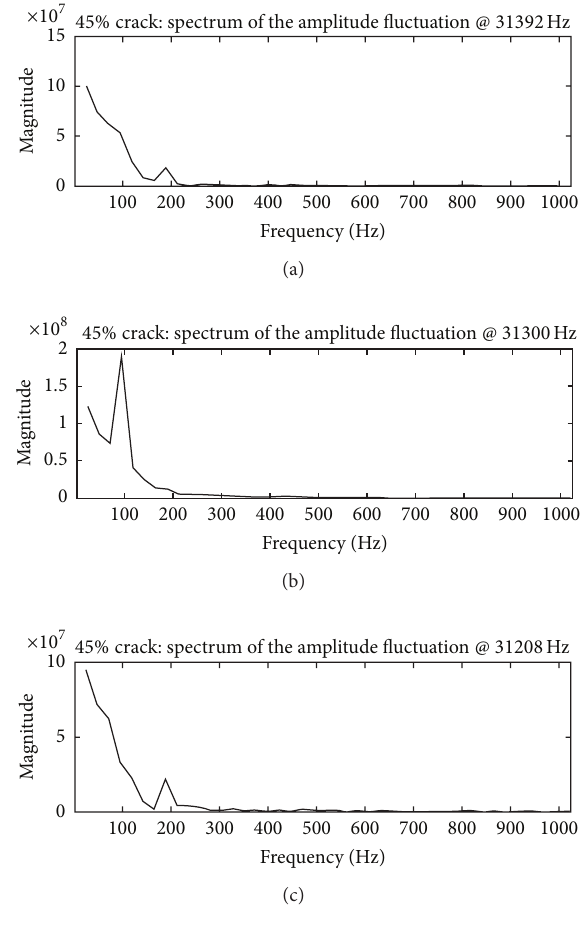
Figure 5: The spectrum of the amplitude fluctuation of the ZAM transform at the corresponding VAM frequencies, that is, 31392 Hz (a), 31300 Hz (b), and 31208 Hz (c), for the crack size of 45%,